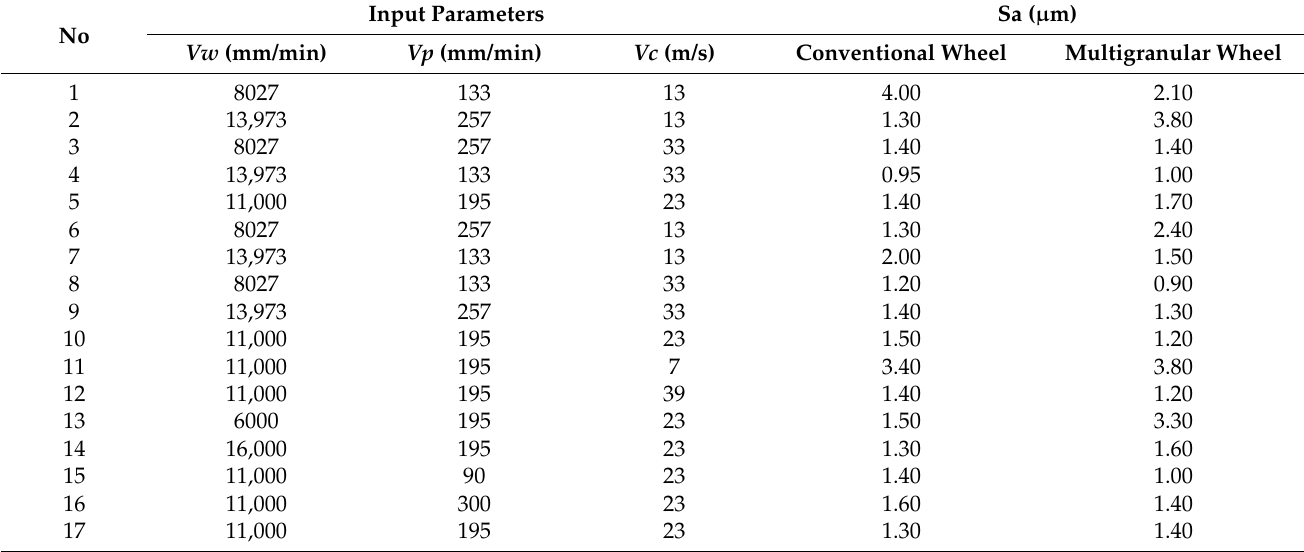
Table 5. Results obtained for a conventional grinding wheel and a multigranular grinding